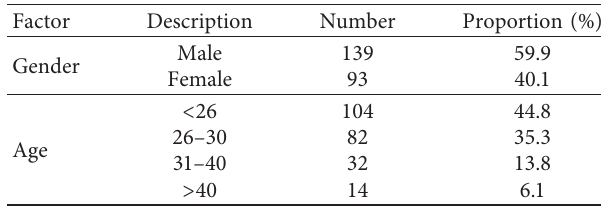
Table 1: Sample basic situation.